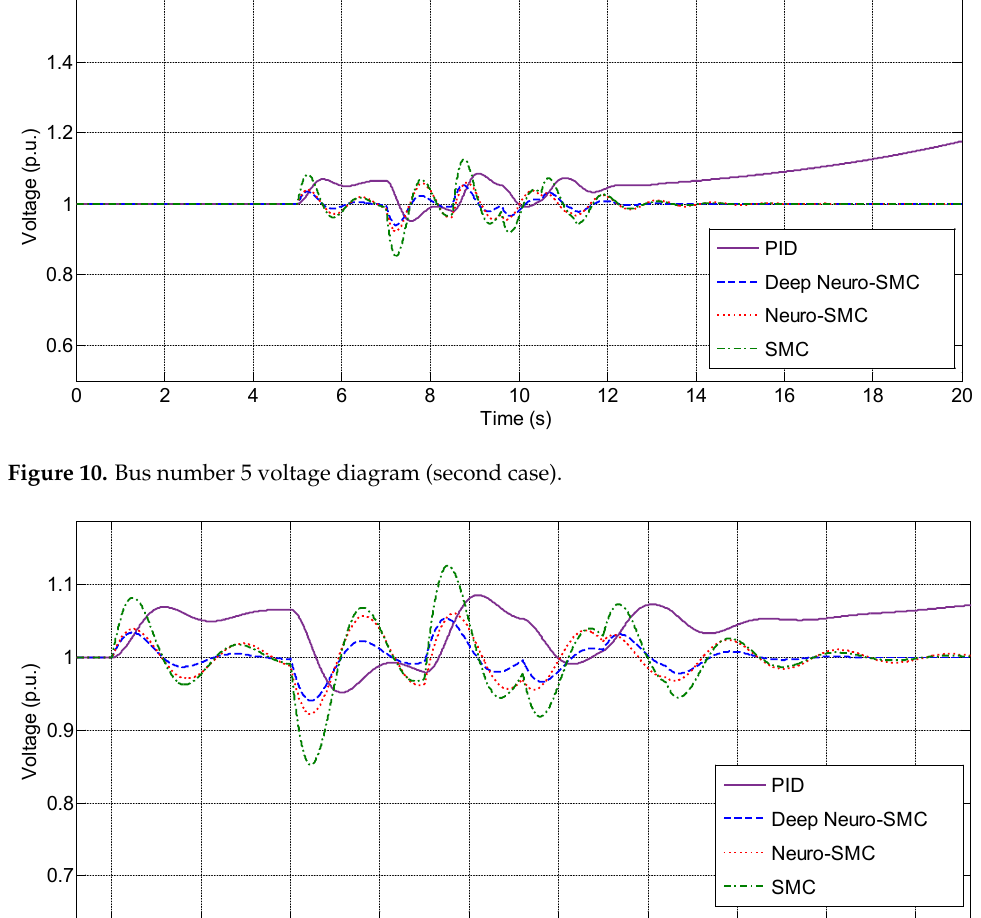
Figure 9. Bus number 5 voltage diagram (first case).